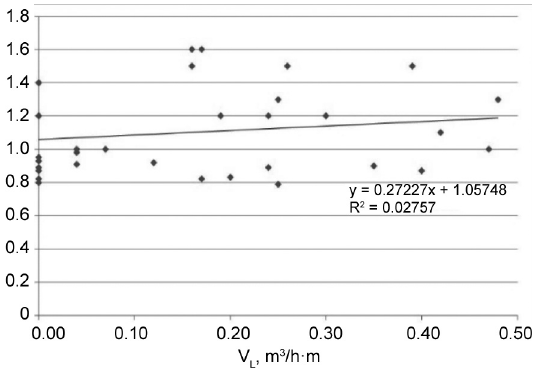
Figure 9. Relationship between thermal transmittance and air permeability